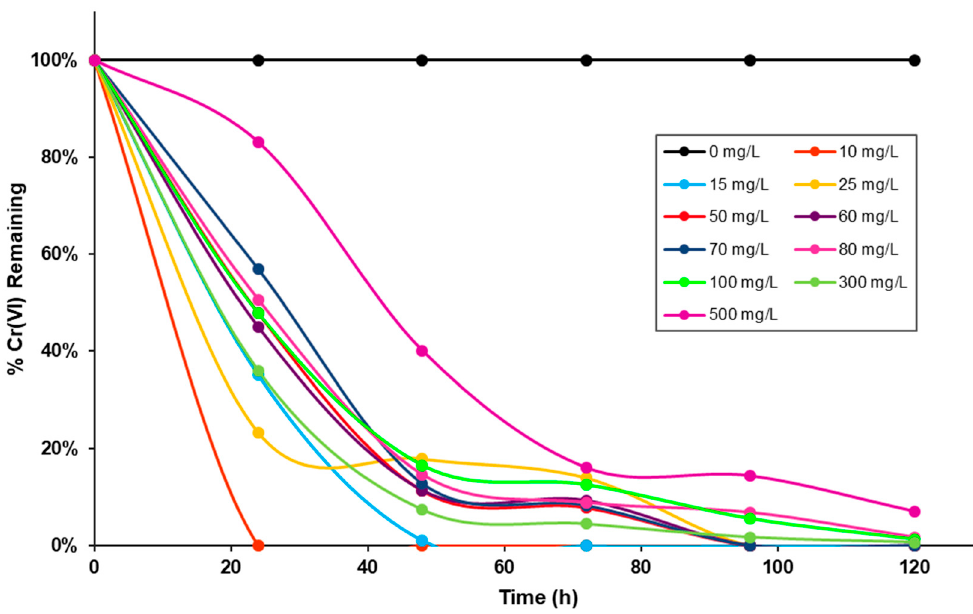
Figure 4. Reduction of Cr(VI) by Stenotrophomonas maltophilia (strain NA2). The cells were cultured on Luria–Bertani broth supplemented of 0, 10, 15, 25, 50, 60, 70, 80, 100, 300 and 500 mg/L Cr(VI). The Cr(VI) reduction activity was measured after incubation for 0, 6, 12, 18, 24, 48, 72, 96 and 120 h at 37 °C.